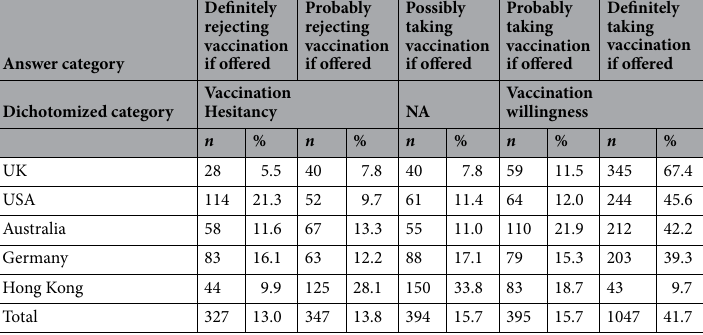
Table 2. Distribution of vaccine willingness across